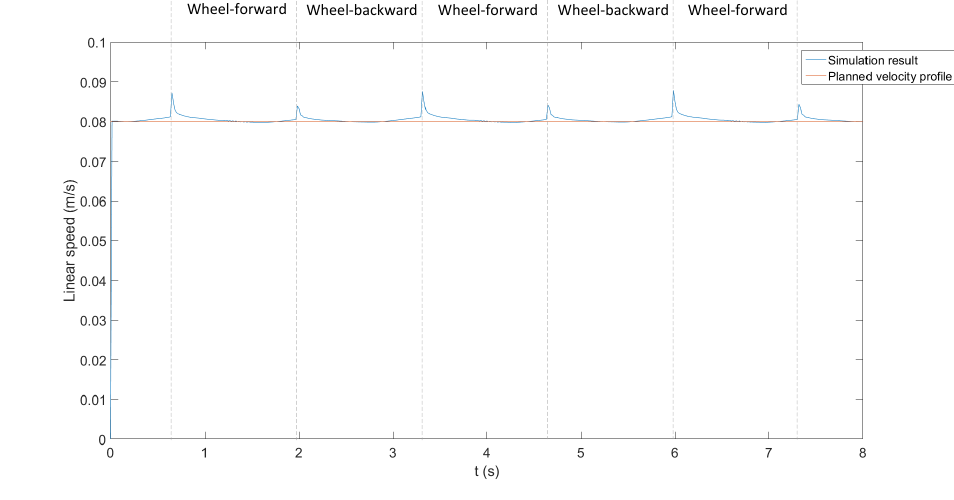
Figure 8. Rover linear velocity during wheel walking. Peaks on the walking joints causes the same effect over the linear velocity of the